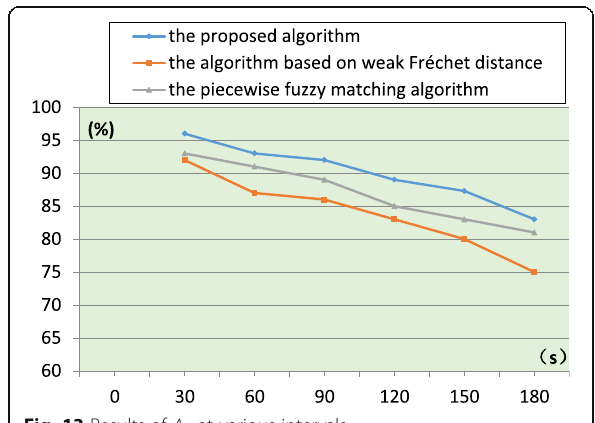
Fig. 13 Results of A N at various intervals